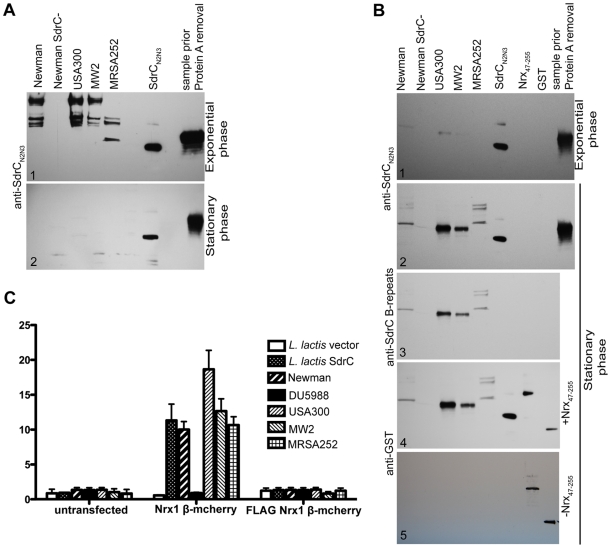
SdrC mediates S. aureus clinical isolates adherence to Nrxβ expressing cells.(A) Western immunobloting to detect SdrC expression on the surface of different bacterial strains. S. aureus Newman, DU5988 and clinical strains USA300, MW2, MRSA252 were grown to exponential phase (A1) or stationary phase (A2) in BHI. CWA proteins extracted as described in material and methods were separated on 4–15% gradient SDS-PAGE gradient gels, transferred to nitrocellulose and probed with anti-SdrC serum. (B) Culture supernatants from the above mentioned strains grown to exponential (B1) or stationary phase (B2) were concentrated and separated on 4–15% gradient SDS-PAGE gradient gels after protein A removal. After gel separation the proteins were transferred to nitrocellulose and probed with anti-SdrC serum (B1 and B2). The nitrocellulose blot corresponding to the stationary phase supernatants was stripped and re-probed with anti-SdrC B-repeats antibody (B3). The same blot was stripped again and probed with Nrx47-255. The binding of Nrx1β was detected with anti-GST serum (B4). A second membrane (B5) was not incubated with Nrx47-255 and therefore served as control for the primary and secondary sera. (C) L. lactis empty vector, L. lactis SdrC, S. aureus Newman, DU5988 (S. aureus Newman sdrC::Emr), USA300, MW2 or MRSA252 were incubated with CHOK1 transiently transfected with Nrx1β-mCherry or FLAG Nrx1β-mCherry grown in 24 well plates. Attachment of bacteria was reported as a percentage of total bacteria at the end of incubation. Values shown represent mean±SD of three experiments (*p≤0.001).